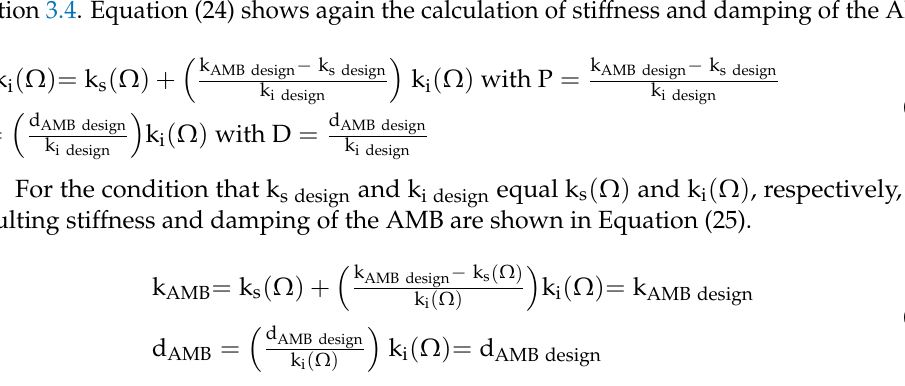
Figure 8. ( a ) Campbell diagram with CFC and C att = 0.5 ; ( b ) decay rate with CFC and C att = 0.5 .